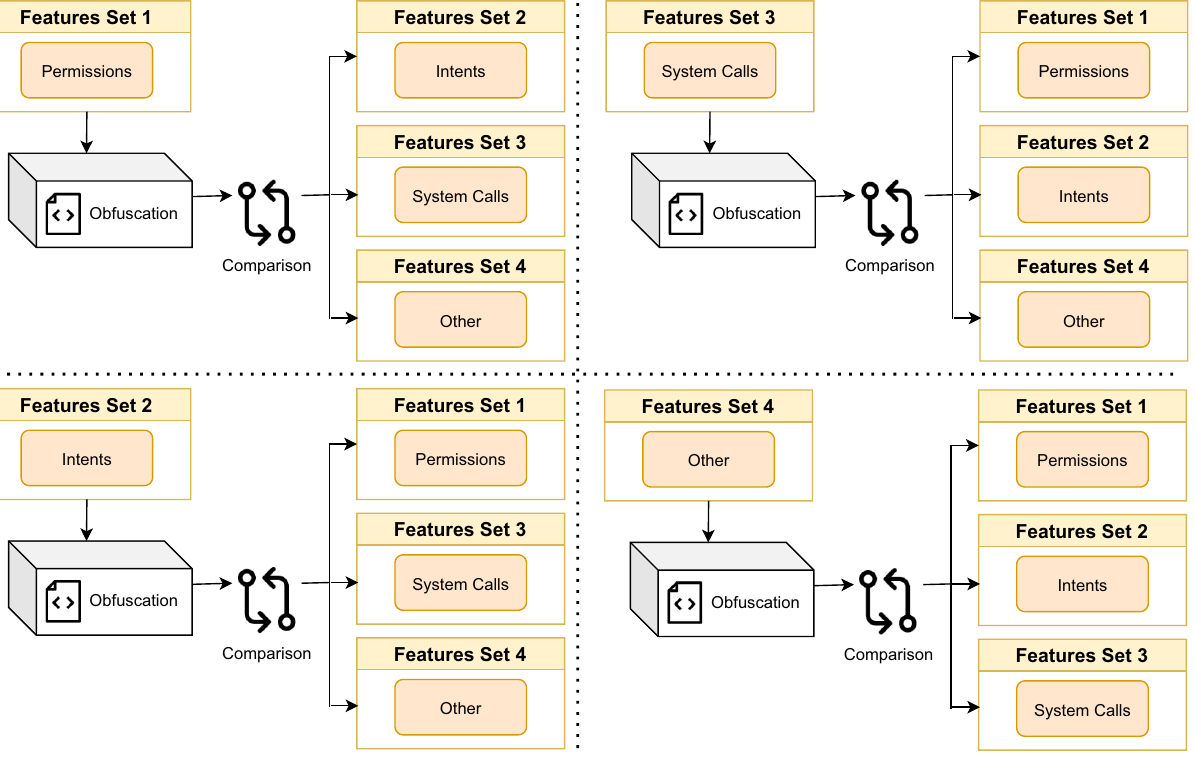
Figure 2. Employment of the feature-obfuscated technique on the proposed